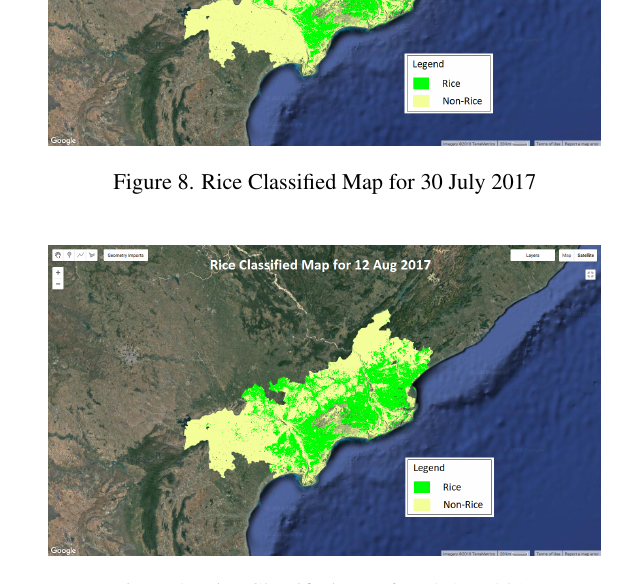
Figure 9. Rice Classified Map for 12 Aug